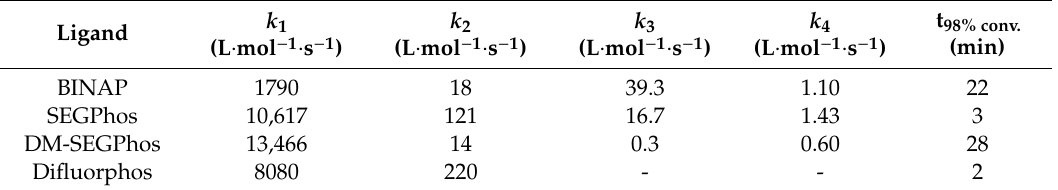
Table 1. Rate constants of the ligand exchange reactions described in Schemes 4 and 5 for BINAP, SEGPhos, DM-SEGPhos, and Difluorphos [54].